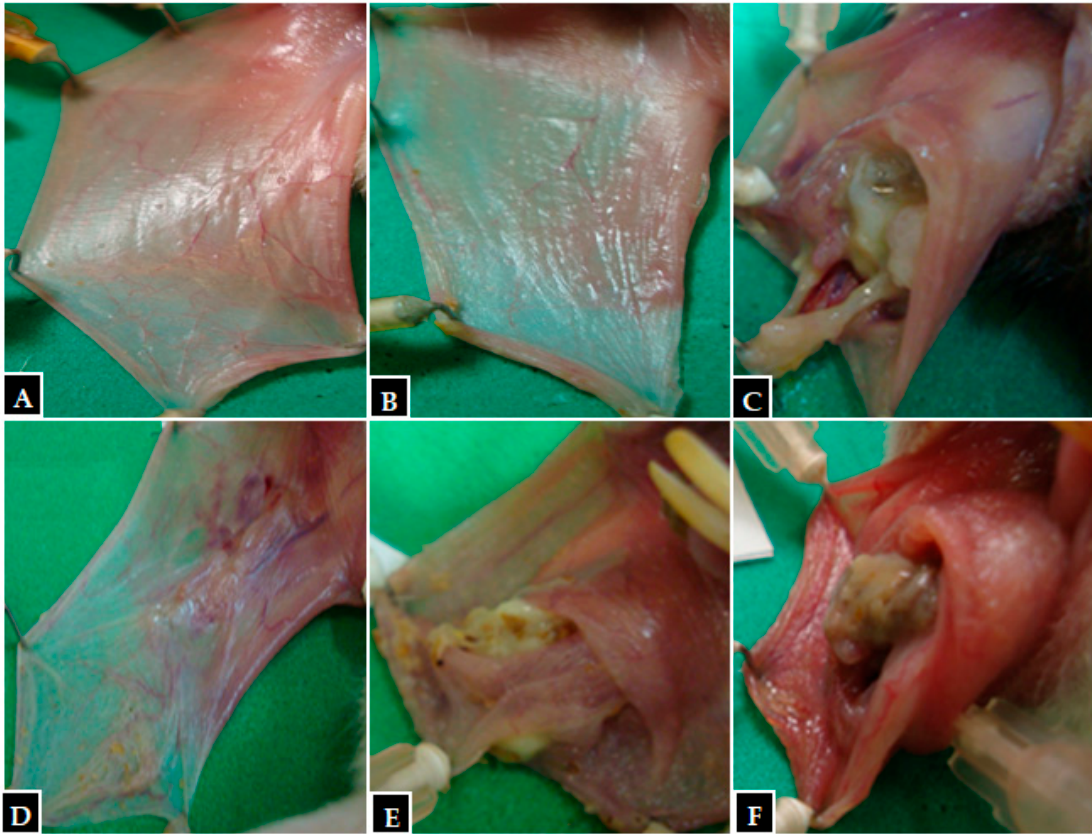
Figure 2. Macroscopic images from hamster oral mucosa with oral mucositis (OM) induced by 5-fluorouracil (5-FU) and mechanical trauma (MT), treated with PLGA-DEX NPs. ( A ) Normal group: animals not subjected to induction of OM